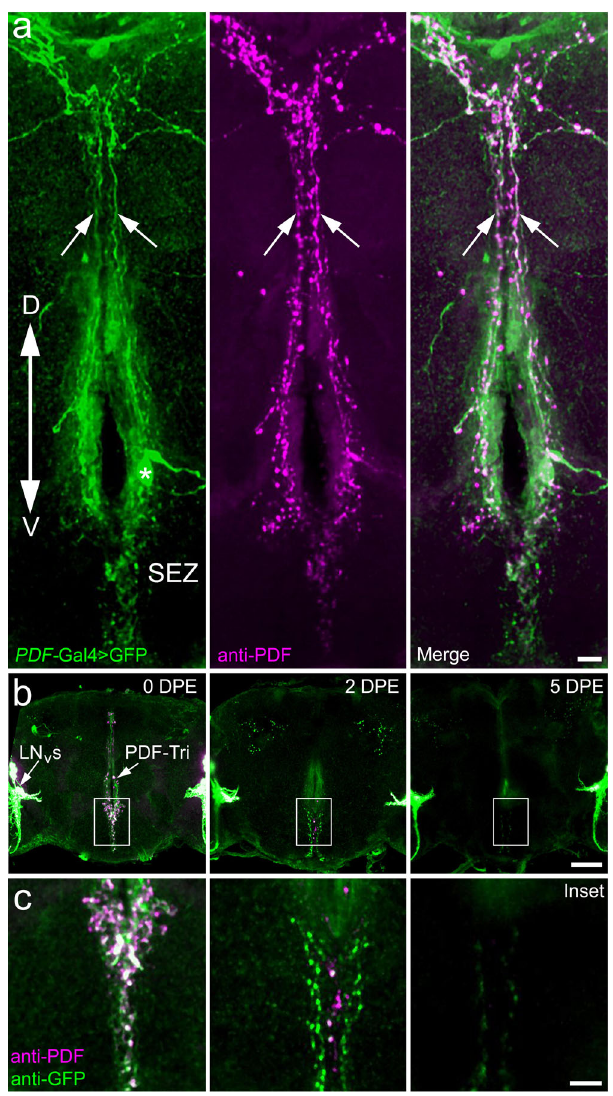
Fig. 1 Central brain PDF-Tri neurons are transient and eliminated following development. a Central brain PDF-Tri neurons in a newly eclosed adult Drosophila co-labeled for PDF -Gal4-driven UAS-mCD8::GFP ( PDF > GFP, green, left), anti-PDF (magenta, middle), and merged (right). The dorsal (D) – ventral (V) orientation is indicated, with the PDF-Tri neuron soma (asterisk) dorsal to the subesophageal zone (SEZ) and axons projecting via the median bundle (arrows). Scale bar: 10 μ m. b PDF-Tri neuron clearance shown in days post eclosion (DPE) at 25 °C. Low- magni fi cation whole-brain images are co-labeled for both membrane marker PDF > GFP (green) and anti-PDF (magenta), as above in panel a , with the developmentally transient central PDF-Tri neurons and adult- persisting ventral lateral neurons (LN V s). Scale bar: 50 μ m. c High- magni fi cation images of the PDF-Tri neurons (boxed central brain region in panel b ). The timing sequence shows progressive elimination of the PDF-Tri neurons over the fi rst 5 days of post-eclosion development. Scale bar: 12 μ m. Images are representative of three independent